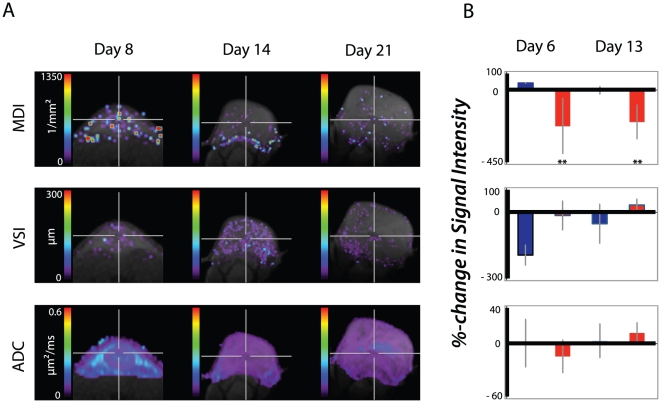
Effect of treatment on tumor angiogenesis.(A) Monitoring PTK787 treatment effects on changes in tumor microvessel density index (MDI), tumor vessel size (VSI) and apparent diffusion coefficient (ADC) during tumor growth and treatment. PTK787 treatment started at day 8 after tumor inoculation. (B) Quantitative analysis of vascular variables after 6 days and 13 days of PTK787 treatment. The blue bars represent the vehicle treated tumors and the red bars the PTK787 treated tumors.